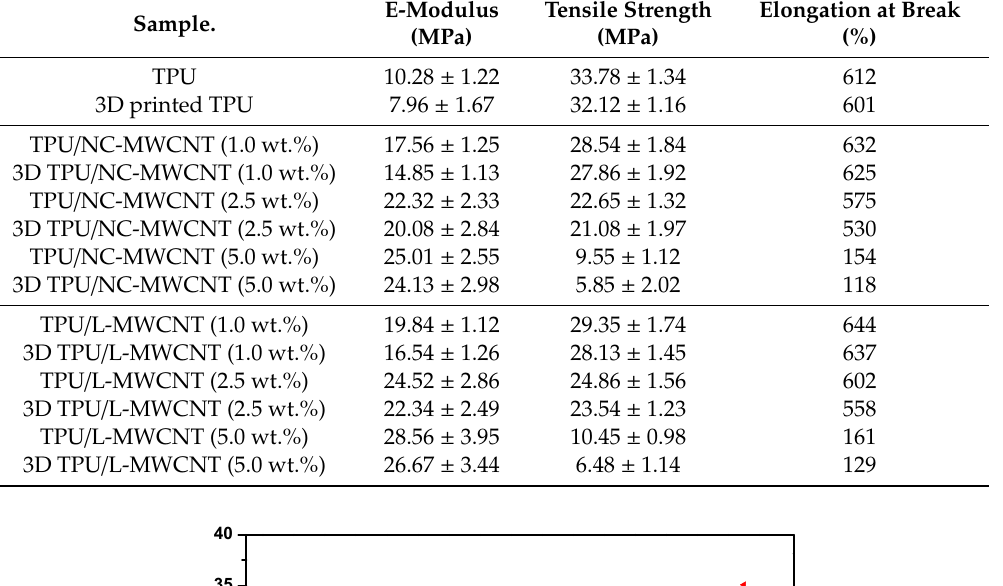
Table 1. Modulus, tensile strength and elongation at break of the extruded TPU, TPU / NC-MWCNT and